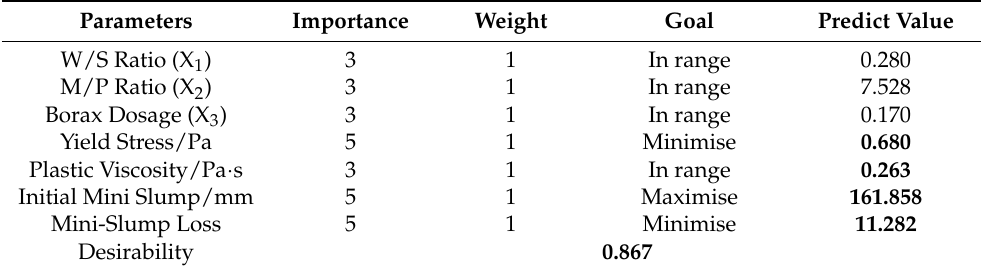
Table 10. Characteristics of numerical optimisation.